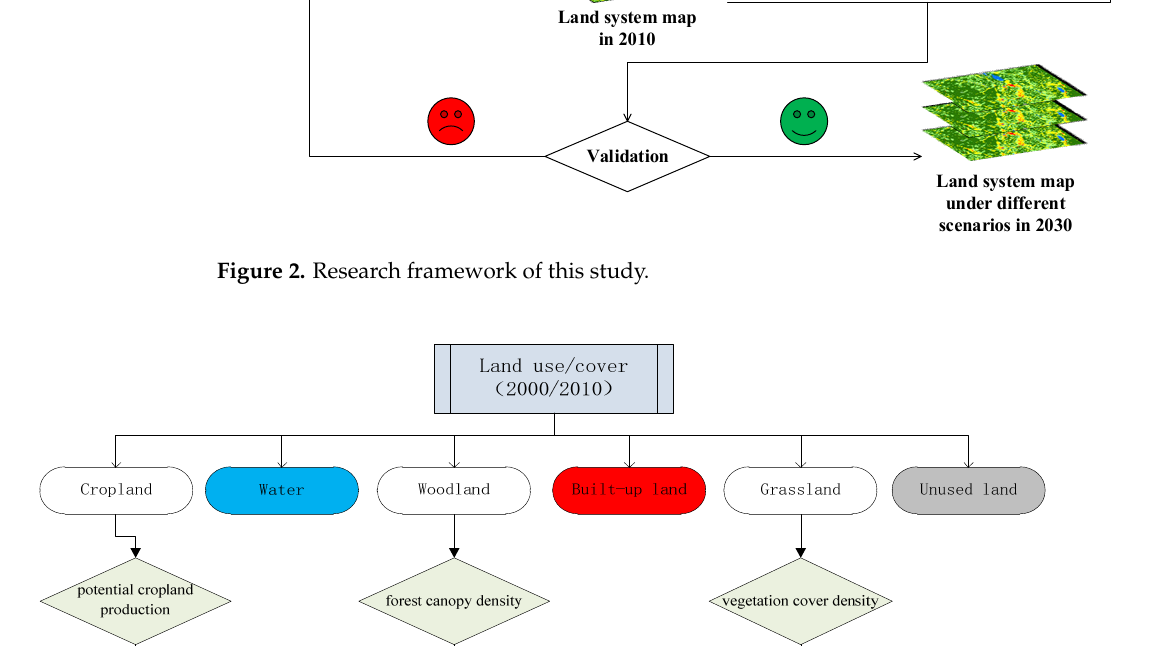
Figure 4. Results of land system delineation in ( a ) 2000, ( b ) 2010. 2.4. Parameter Setting of the CLUMondo Model The CLUMondo model is a dynamic and spatially intuitive land-use model that rep- resents the latest developments based on a series of models in the framework for the Con- version of Land Use and its Effects (CLUE) model. It is designed to simulate changes in land cover and the degree of land use. The core of the CLUMondo model is a combination of a land-use simulation based on an empirical analysis of the suitability of the given lo- cation and a dynamic simulation of the competition and interaction between different land systems. A total of 20 driving factors, including climate, topography, soil attributes, socioeconomic concerns, and vegetation types, were used as explanatory variables for changes to the land system in the Hengduan Mountain region. Factors with correlation coefficients higher than 0.8 were eliminated by multi-collinearity analysis. Logistic regres- sion was then established for each land system and the factors driving it, and the results of fitting were determined by the level of significance and AUC (area under the curve), which represent the accuracy of the analysis of regression (Table S2). Resistance to con- version is a key factor influencing changes to the land system and was assigned values ranging from 0 (easy conversion) to 1 (irreversible change). In general, types of land use with high capital investment or an irreversible impact on the environment are difficult to